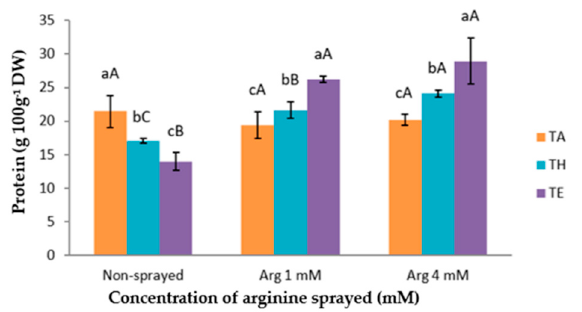
Figure 1. Content of protein (g 100g − 1 DW) in the florets of cauliflower plants subjected to different temperatures and sprayed with two different concentrations of foliar arginine (1 and 4 mM). The data are presented as the treatment means ( n = 4). Different small letters indicate significant differences between temperatures, and different capital letters indicate significant differences between arginine treatments, at the same temperature. The mean values of the main effects are shown (ns, not significant; * p ≤ 0.05; ** p ≤ 0.005; *** p ≤ 0.001). Abbreviations: Arg: arginine, T: temperature.